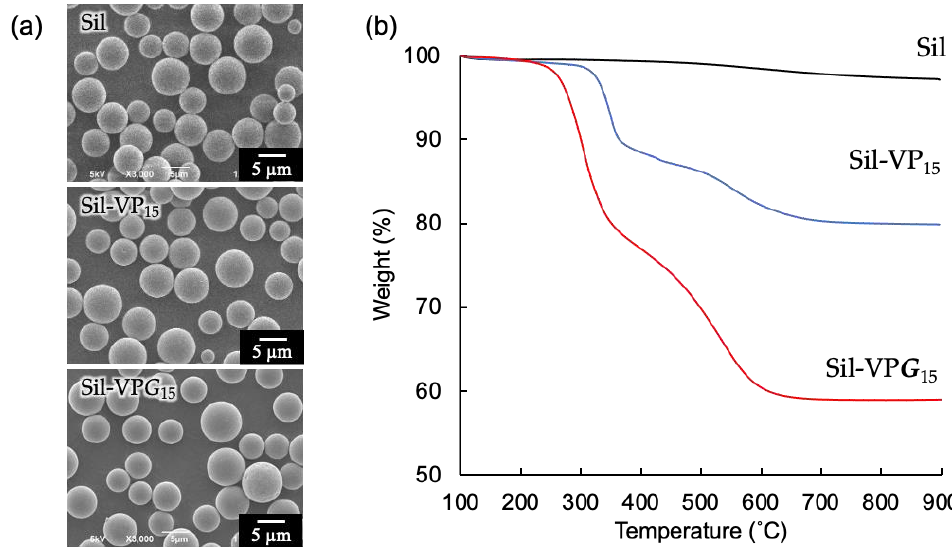
Figure 2. ( a ) SEM images and ( b ) DSC thermograms of Sil, Sil − VP 15 , and Sil − VP G 15 . The particles were coated with osmium for the SEM observations. Heating rate for DSC: 10 °C min −1 .